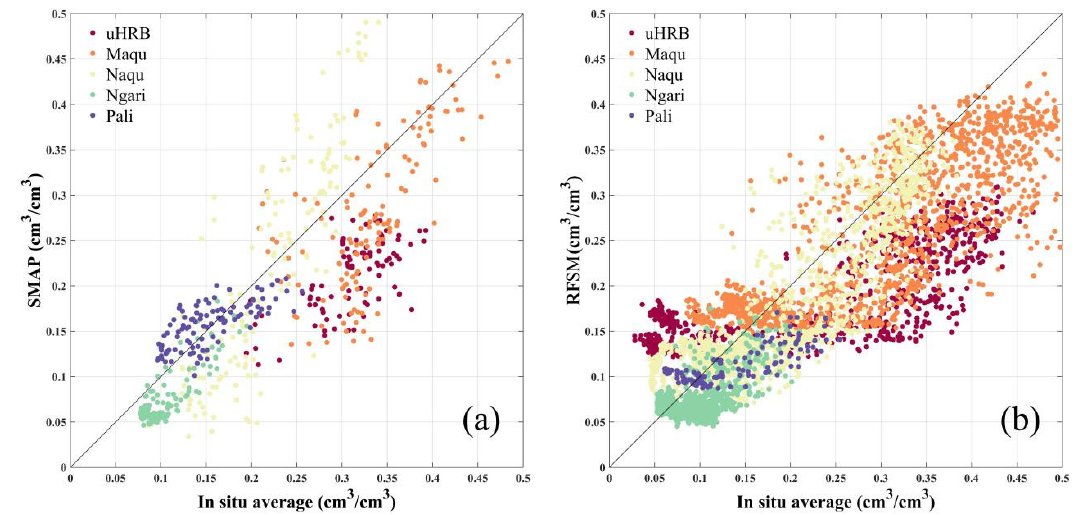
Figure 7. Scatter plots of ( a ) SMAP and ( b ) RFSM over the uHRB, Maqu, Naqu, Ngari and Pali.